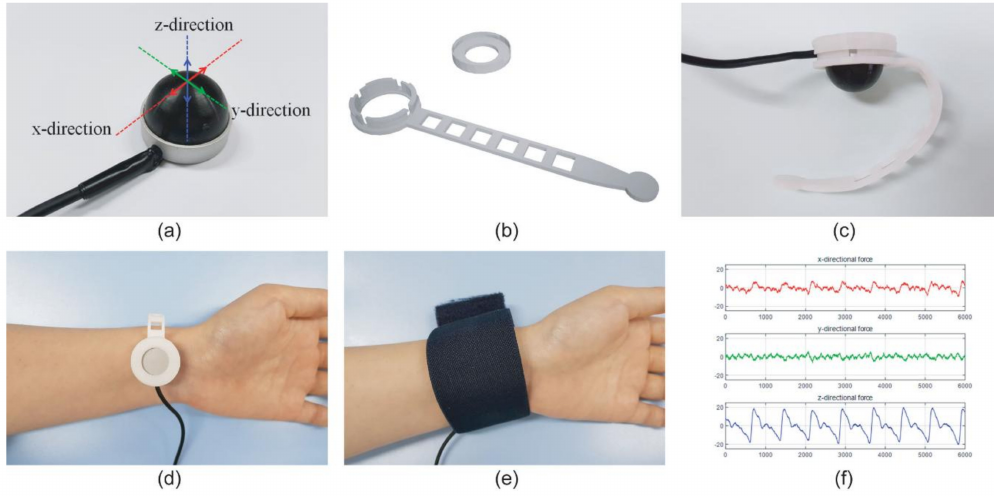
Figure 1. ( a ) The three-axis tactile force sensor; ( b ) Three-dimensional (3D) schematic of semicircular bracelet; ( c ) Semicircular bracelet with three-axis tactile sensor and its application onto the wrist for monitoring non-invasive blood pressure (NIBP) on the radial artery ( d ); ( e ) Elastic wristband over the system to ensure stable position; ( f ) Data from the three-axis tactile sensor with pulse